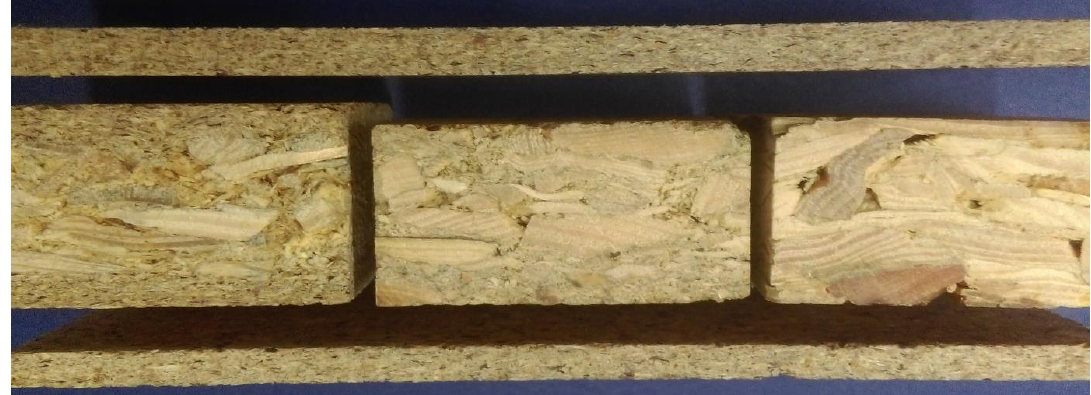
Figure 1. Manufactured boards: below and above-microchips boards, from left to right: chip-sawdust with outer layer from microchips (FRI), chip-sawdust (PT) and chipboards (PZ).